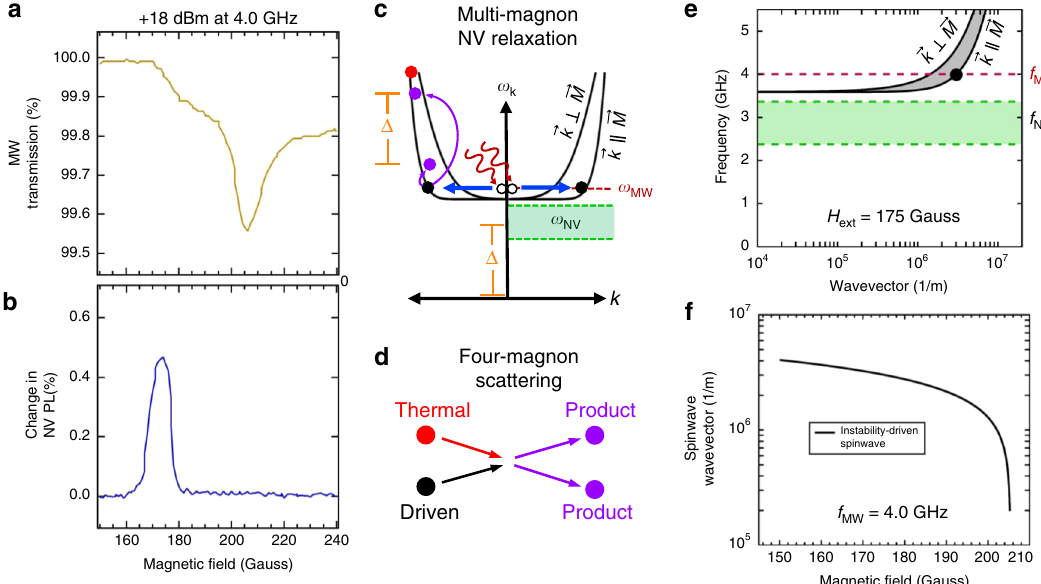
Fig. 4 NV detection of spinwave instability in the multi-magnon NV relaxation regime. a Microwave absorption during a static magnetic fi eld sweep at 4.0GHz and + 18dBm microwave power shows a uniform mode FMR absorption signal at 206 Gauss and an instability shoulder at lower fi eld. b Simultaneously collected NV signal shows relaxation only at the lowest fi eld where the instability is excited, and NV relaxation is minimal at the uniform mode FMR condition. c At these magnetic fi elds, the minimum of the spinwave manifold is lifted to higher frequency than the NV states, and there are no NV resonant magnons possible. An increase in NV-resonant magnetic fi eld noise from multiple magnons generated in the four magnon scattering process ( d ) leads to a change in NV PL. e Calculated spinwave manifold (gray) and NV center frequency range (green) at 175 Gauss gives the wavevector of the 4.0GHz instability-driven magnon (3.2×10 6 m − 1 , black circle). f Calculated wavevector of 4.0GHz instability-driven spinwave as a function of magnetic fi